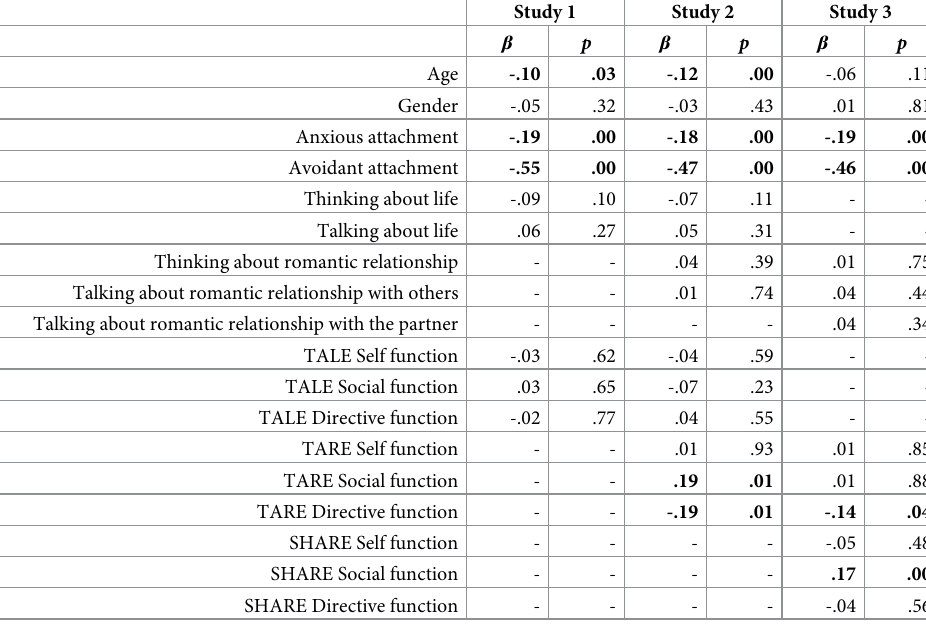
Table 4. Regression results for relationship satisfaction across